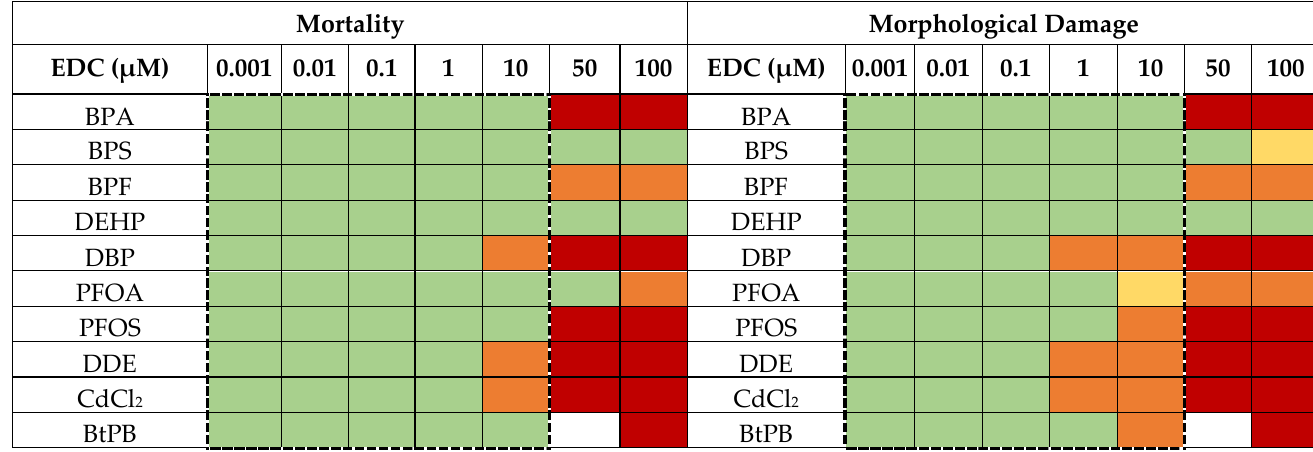
Table 2. Evaluation of EDC toxicity on zebrafish larvae. The toxicity of each compound was evaluated in terms of mortality and morphological damage: green 0–10%, yellow 10–30%, orange 30–80%, red 100% of affected larvae. The dotted lines indicate the concentration ranges of each compound tested with the StAZ.